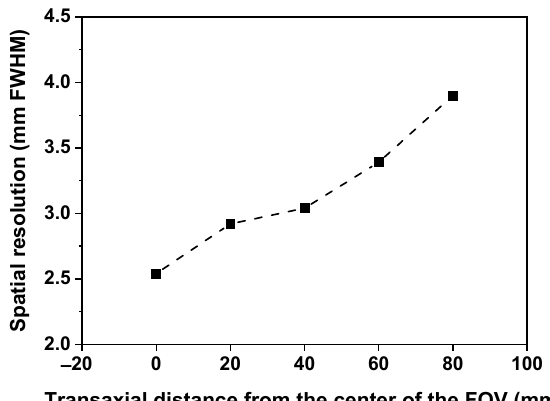
Figure 11. Spatial resolution of the TOF brain PET as a function of the transaxial distance from the center of the FOV.